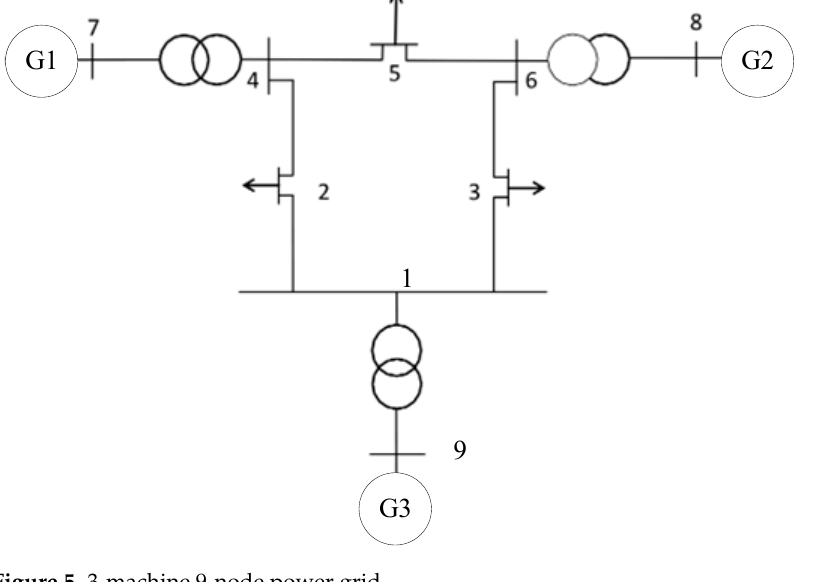
Table 4. Partial unit parameters.